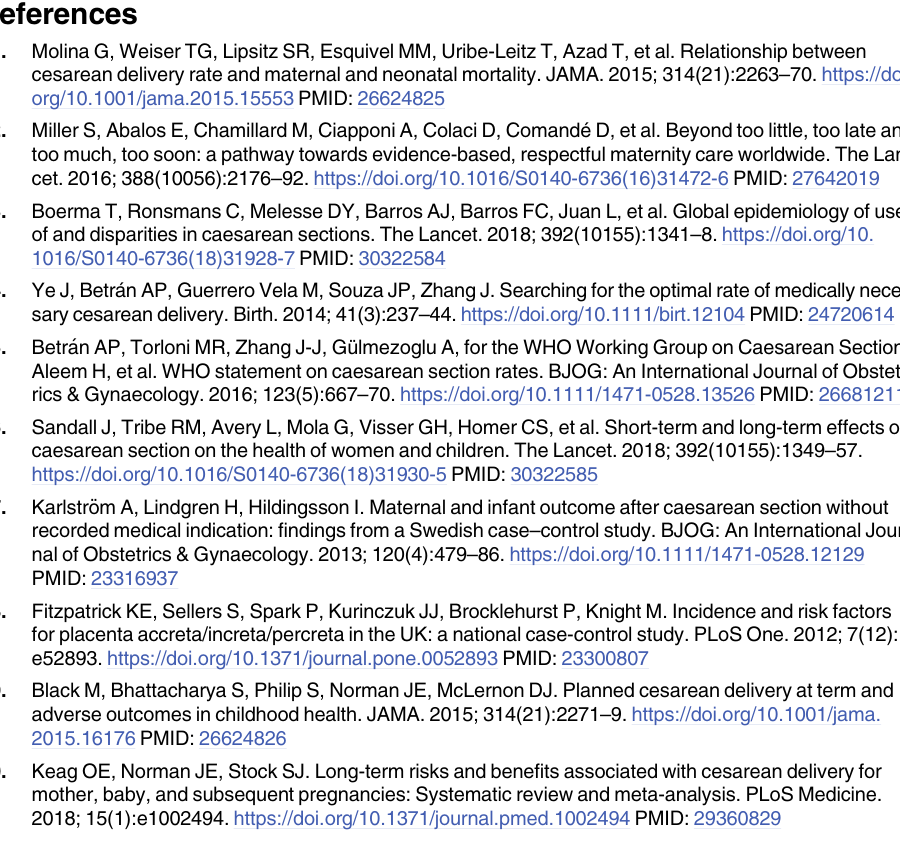
S2 Table. The change in the proportion of caesarean section over time. Values are percent- ages (95% Confidence intervals). S3 Table. Use of caesarean section by wealth index, delivery place, country and survey year. Values are percentages (95% Confidence